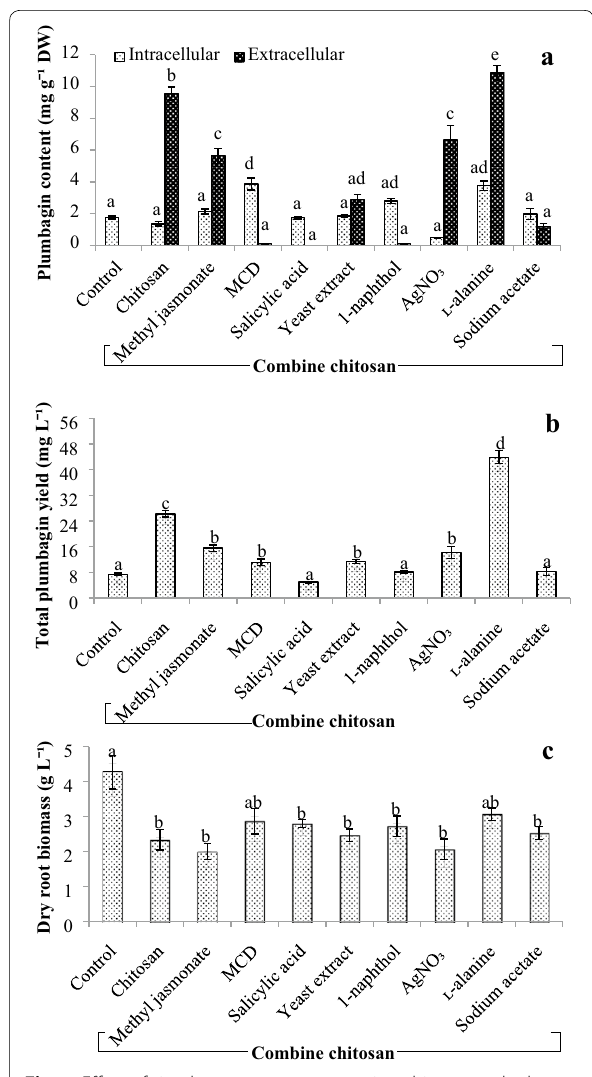
Fig. 1 Effect of simultaneous treatments using chitosan and other elicitors on a plumbagin content; b total plumbagin yield; c dry root biomass. Fourteen-day P. indica root cultures were treated with 150 mg chitosan L − 1 (singly) or combined with methyl jasmonate, salicylic acid, 1-naphthol, yeast extract, MCD, AgNO 3 , sodium acetate and ʟ -alanine. Control is untreated root cultures with equal amount of distilled water or 2% ethanol added on the 14th day. Measurements were taken after 72-h treatment from day 14 treatments. Values are mean SE of triplicate experiments. Data ± were analyzed by one-way ANOVA, using Tukey’s test for multiple comparison. Different superscripts letters between the groups are significantly different at p < 0.05. MCD;